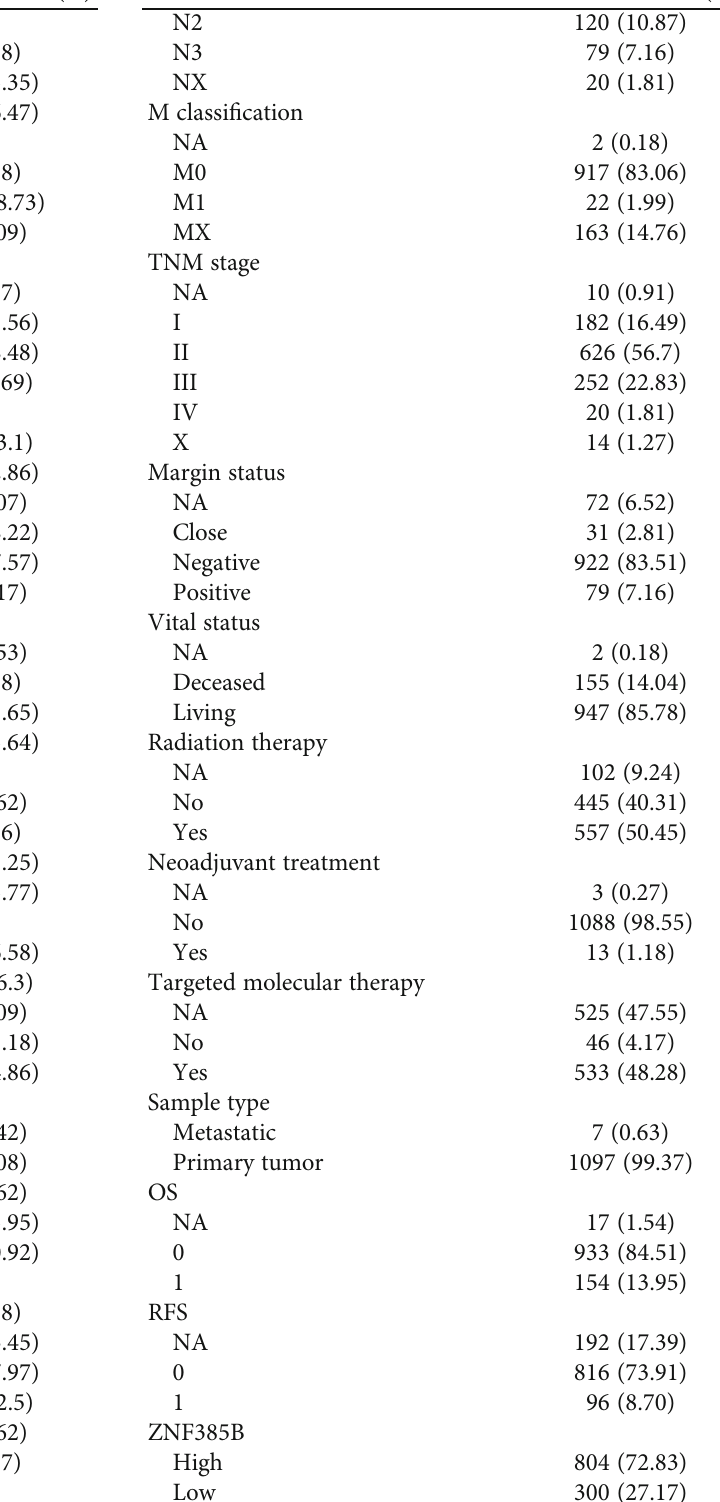
Table 1: Characteristics of the study